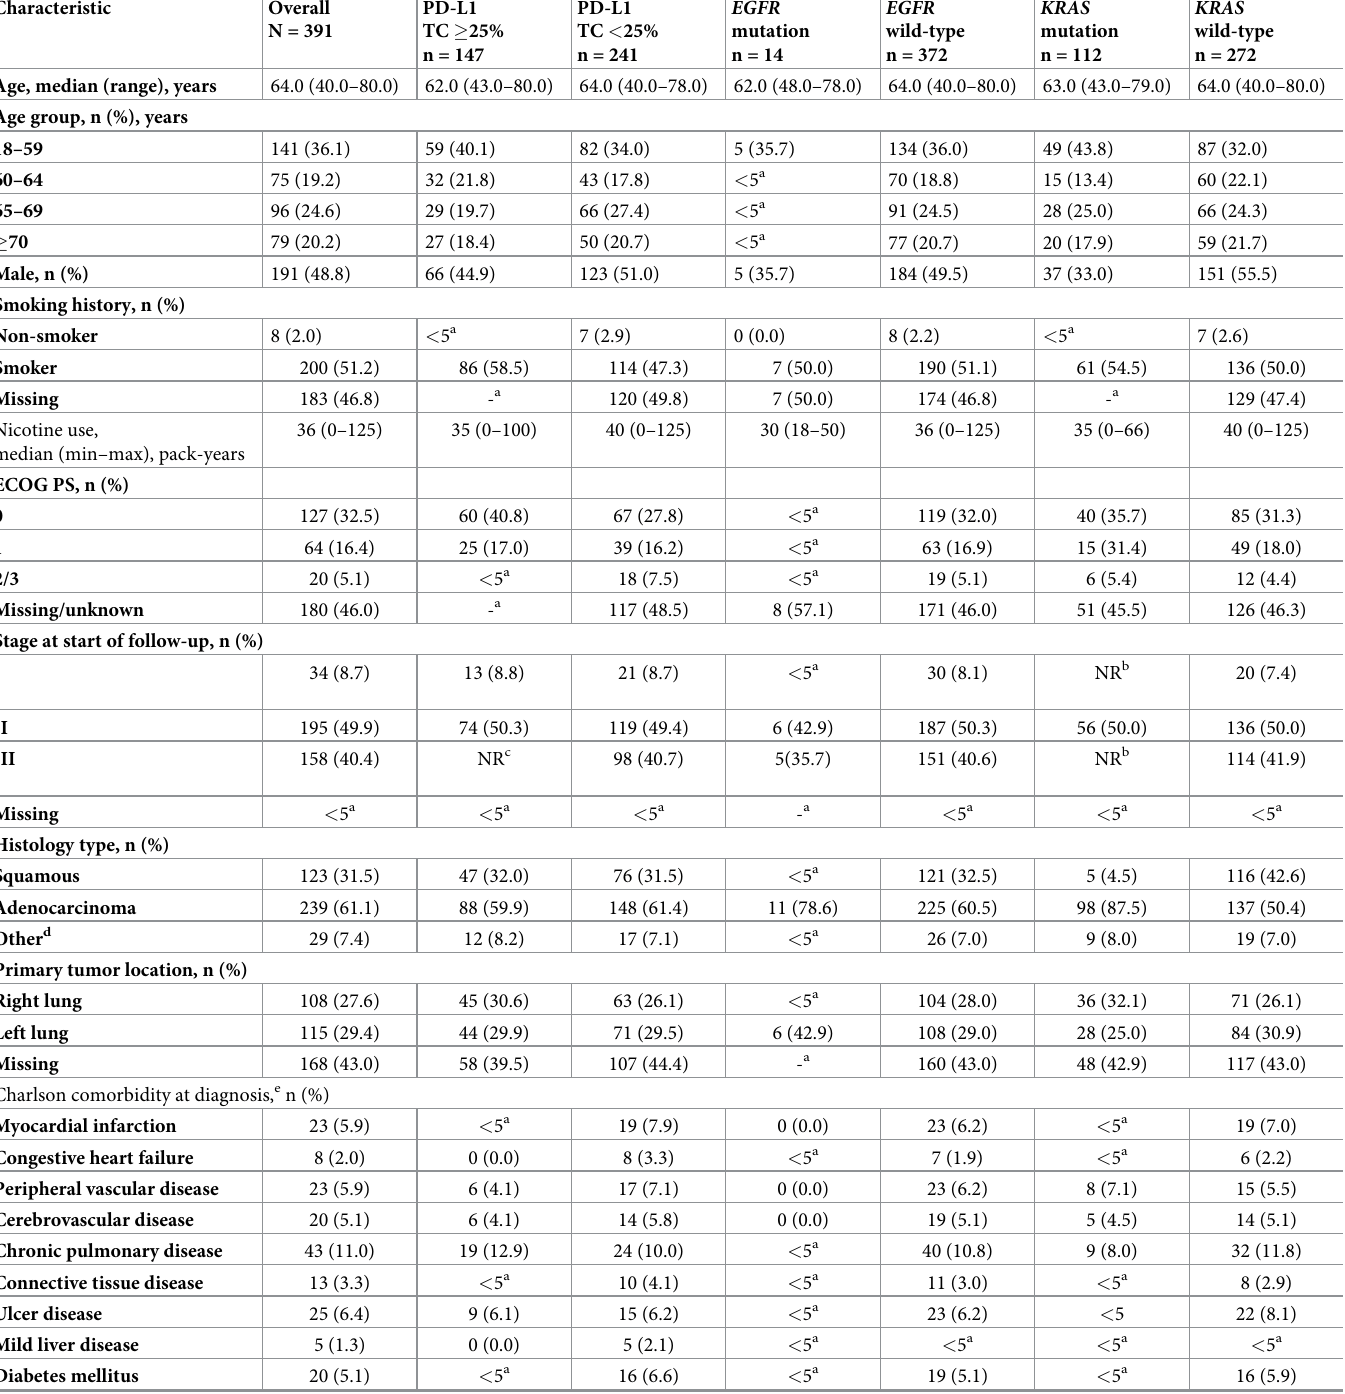
Table 1. Baseline demographics, disease characteristics, and medical history of patients with NSCLC receiving adjuvant chemotherapy by PD-L1 expression level, EGFR mutation, and KRAS